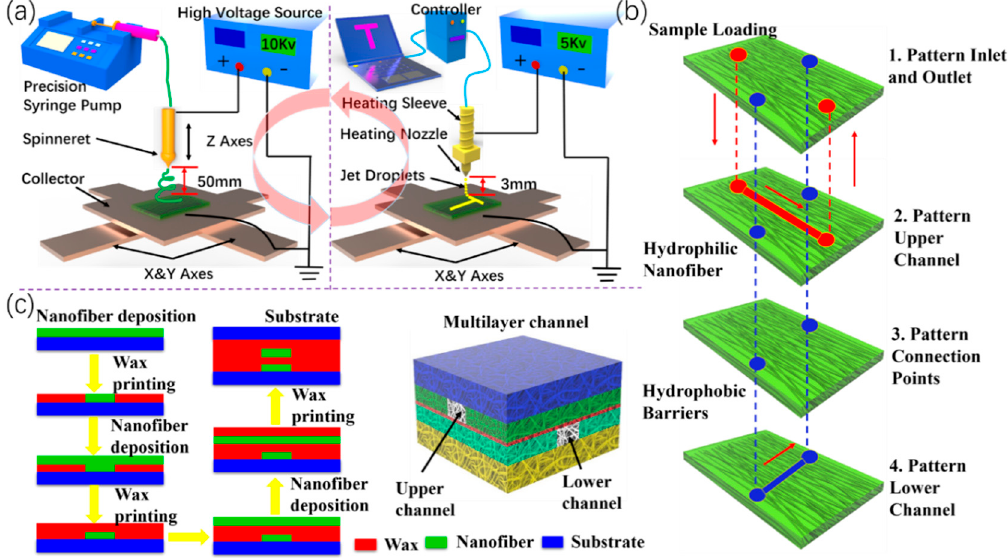
Figure 1. ( a ) Schematic of electrospinning and electrostatic wax printing technology. ( b ) Layered schematic of multilayer channel structure. ( c ) Fabrication process of 3D multilayer channels and final multilayer structure with upper and lower flow